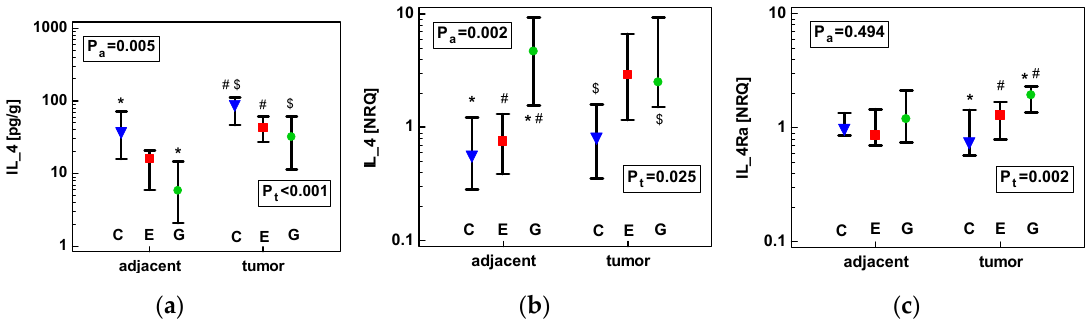
Figure 4. Effect of anatomical site on tumor and tumor-adjacent tissue expression of: ( a ) IL-4 protein; ( b ) IL4 mRNA; ( c ) IL4Ra mRNA. Data analyzed as logs using one-way ANOVA and presented as geometric means with 95% confidence interval (whiskers). Blue triangles represent mean values in colorectal cancers (denoted as C); red squares represent mean values in esophageal squamous cell carcinoma (denoted as E); green circles represent mean values in gastric adenocarcinoma (denoted as G). p values for the analysis in adjacent tissue are denoted as P a and for tumor tissue as P t . Statistically significant differences between groups are marked with symbols of the same type (*, #, etc.). Transcriptomic data presented as normalized relative quantities (NRQ).